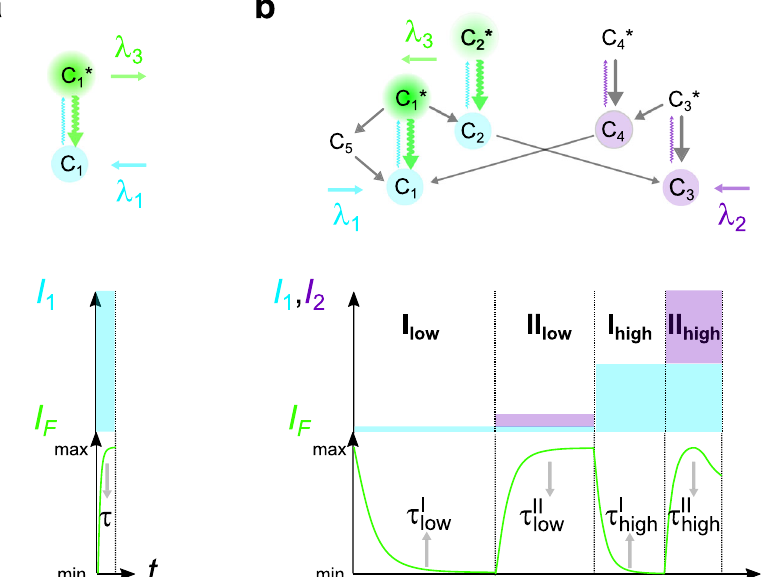
Fig. 1 LIGHTNING opens new dimensions for discriminating fl uorescent labels. a Illumination of the standard absorption/emission photocycle yields three dimensions to discriminate a label: two wavelengths { λ 1 , λ 3 } for photoactivation and fl uorescence emission, and a lifetime τ ; b LIGHTNING uses the